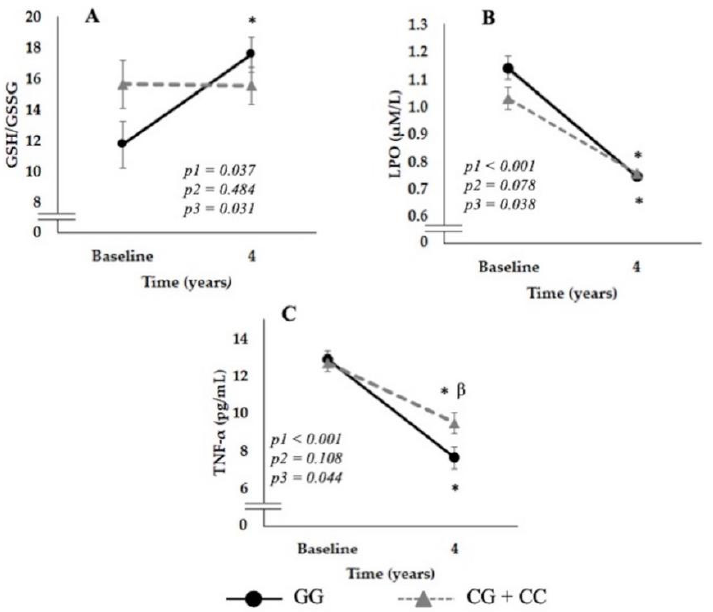
Figure 2. Changes in variables associated with oxidative stress (OxS) and inflammation according to SNP rs7069102 genotype located in SIRT1 gene (Panel A , reduced/oxidized glutathione (GSH/GSSG); B , lipid peroxidation products (LPO); C , tumor necrosis factor-alpha TNF- α ). Data are represented as the mean ± SEM and correspond to ANOVA for repeated measures; where p1: time of follow-up, p2: genotype influence and p3: the interaction of the two factors (time vs. genotype). When post hoc tests were pertinent, we used multiple comparisons with the Sidak correction. * p < 0.05 4 years vs. baseline, β p < 0.05 genotypes in the same time. The data correspond to the popula- tion included in the study selected to the OxS and inflammation analyses where the where 49% carried the GG genotype and 51% carried the C allele.